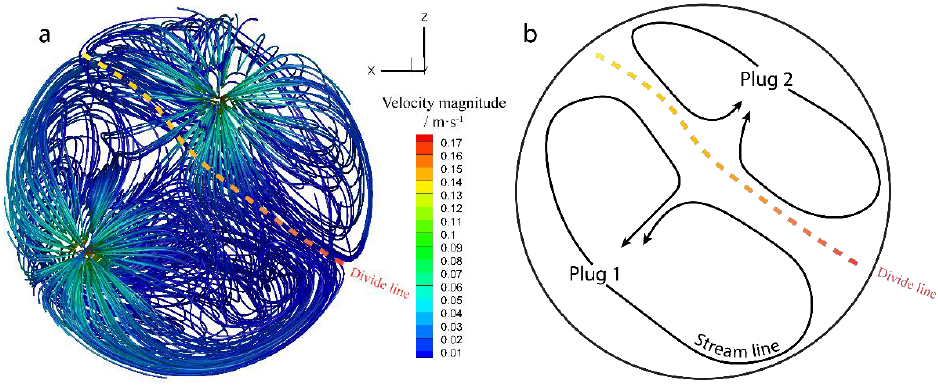
Figure 12. ( a ) The streamline in the top view; ( b ) the schematic of the streamline in the different plugs.